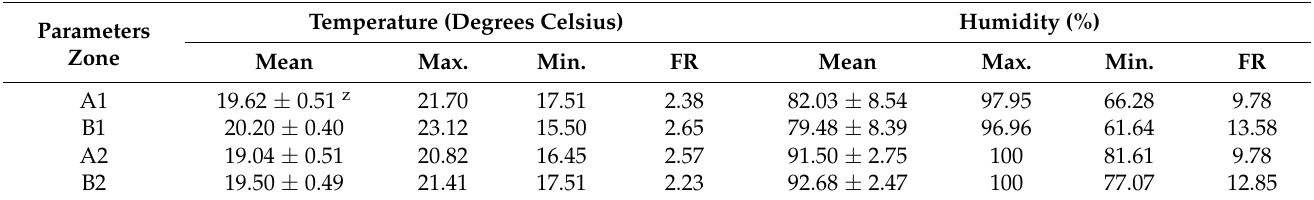
Figure 17. Variation in humidity in cultivation zones ( a ) A1, ( b ) A2, ( c ) B1, and ( d ) B2. Table 5. Variation in temperature and humidity in four zones during tea plant cultivation. The range of fluctuations (FR) is defined in (5) (N = 180 and I = 1440).